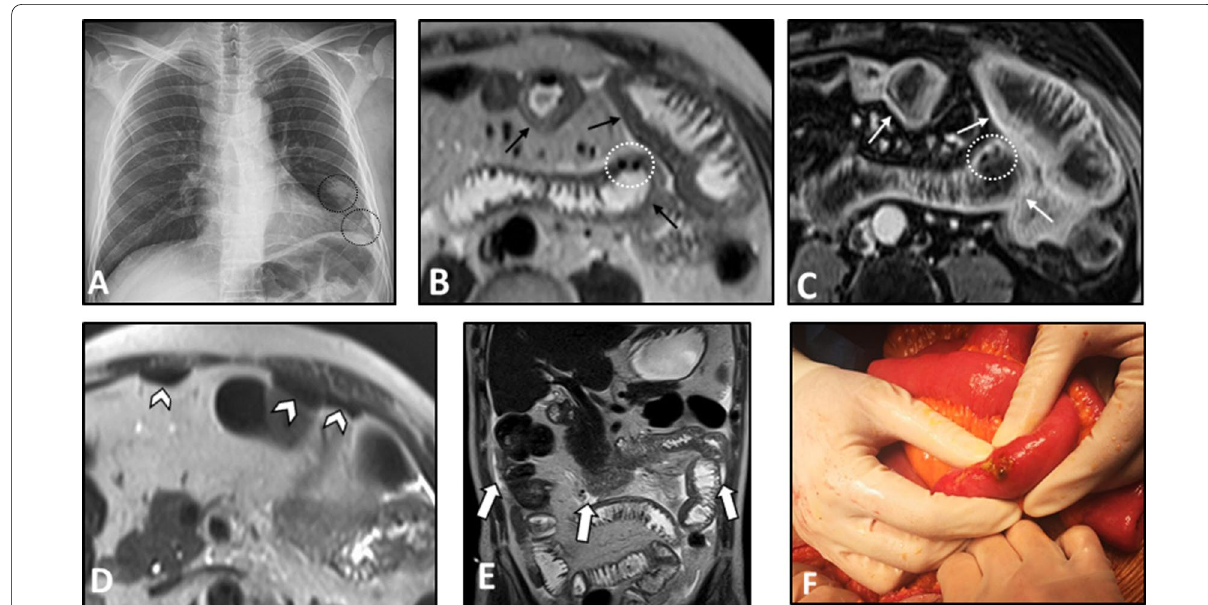
Fig. 6 Intestinal vasculitis and perforation in a 56-year-old male with known ANCA-positive granulomatosis with polyangiitis and long history of immunosuppressive therapy presenting with acute abdominal pain and leukocytosis. Chest X-ray ( A ) shows two pulmonary nodules projecting over the lower zone of the left hemithorax (black dotted ovals). MRE was obtained. Axial T2-W image ( B ) reveals multi-focal segmental mural thickening in jejunal loops (thin black arrows). Axial post-contrast T1-W image ( C ) displays intense mural hyperenhancement (thin white arrows) in the involved segments. Focal intestinal pneumatosis (white dotted ovals) is also evident. Axial T2-W image ( D ) shows pneumoperitoneum (white arrowheads) at the non-dependent portion of the abdominal cavity, indicating bowel perforation. Coronal T2-W image ( E ) demonstrates small amount of free fluid (thick white arrows) at the abdominal cavity. Due to acute nature of presentation, the patient subsequently underwent laparotomy. Intraoperative photograph ( F ) reveals focal bowel necrosis and perforation. No signs of peritonitis were found in the initial examination, more likely due to the immunocompromised status of the